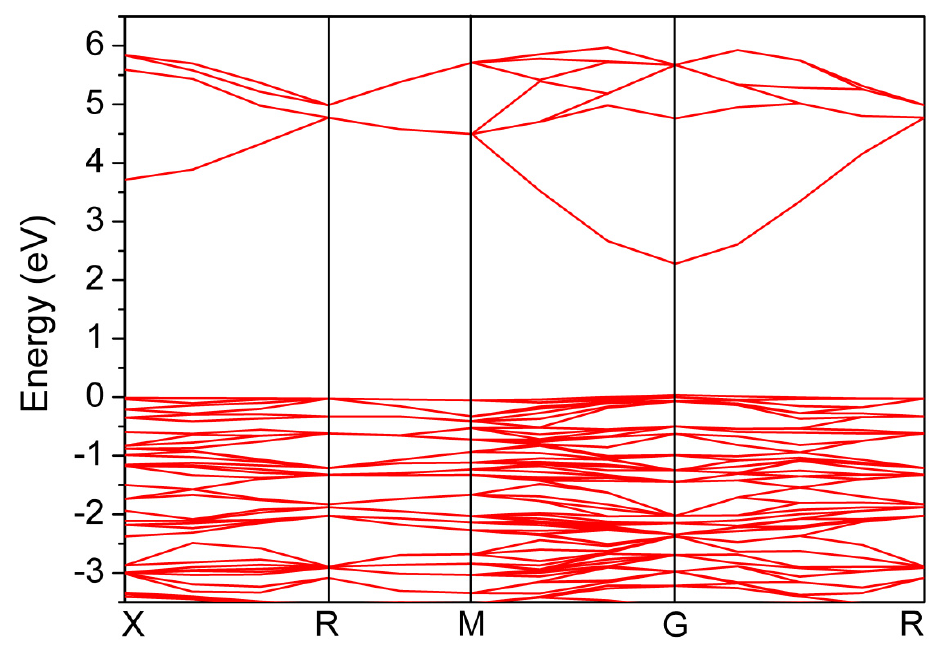
Figure 6. The electronic band structure of ZnGa 2 O 4 .